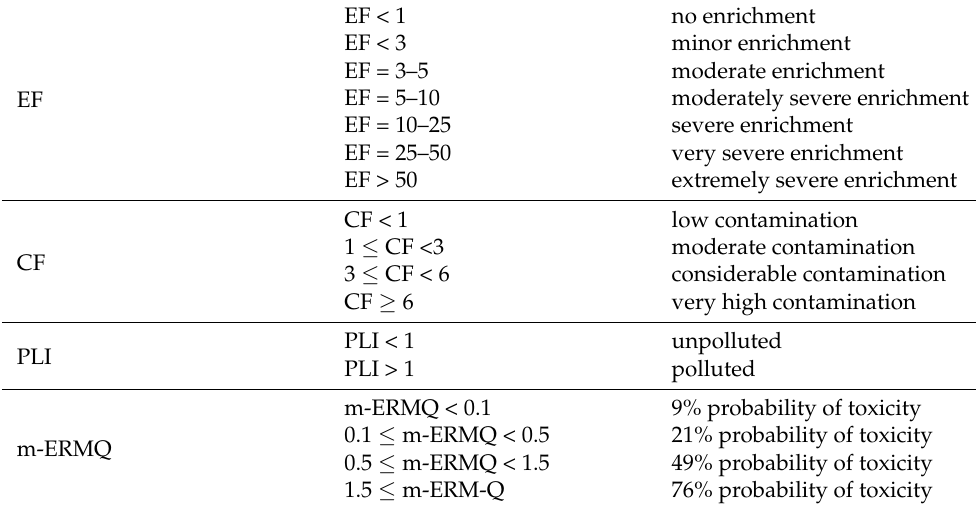
Table 1. Classification of the indices applied in this work.